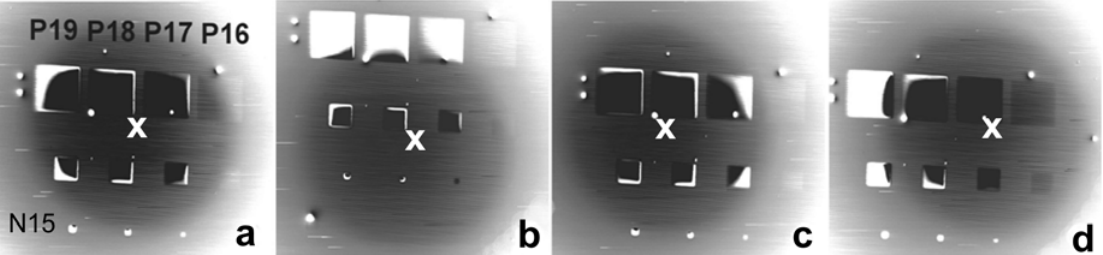
Figure 20. P-type doped rectangles on the n-type Si substrate (Px or Nx means the dopant density of 10 x cm − 3 ), sample immersed in 1 kV/mm field, landing energy of electrons 1.6 eV. Black sites correspond to the total reflection of primary electrons in the detector bore while from white sites the electrons are totally reflected on the detector surface. Layout moves with the sample position slightly varied between frames: ( a ), ( b ), ( c ), and ( d ) show different positions of the pattern group with respect to the optical axis indicated with the